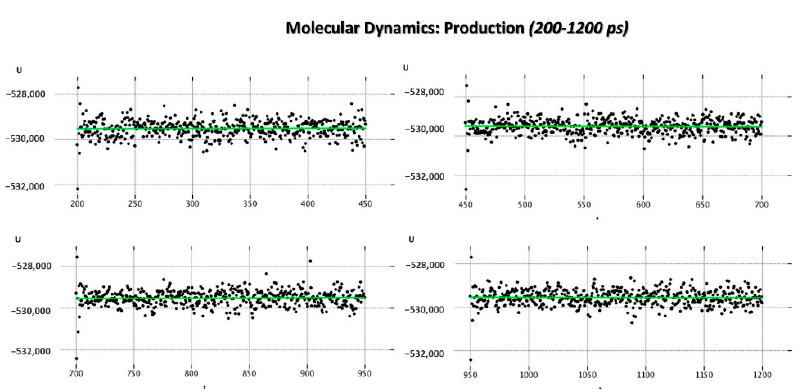
Figure 8. Potential energy (kcal/mol) and kinetic energy (kcal/mol) variation of the 5KWW complex as function of time during MD_P (200–1200 ps) phase.